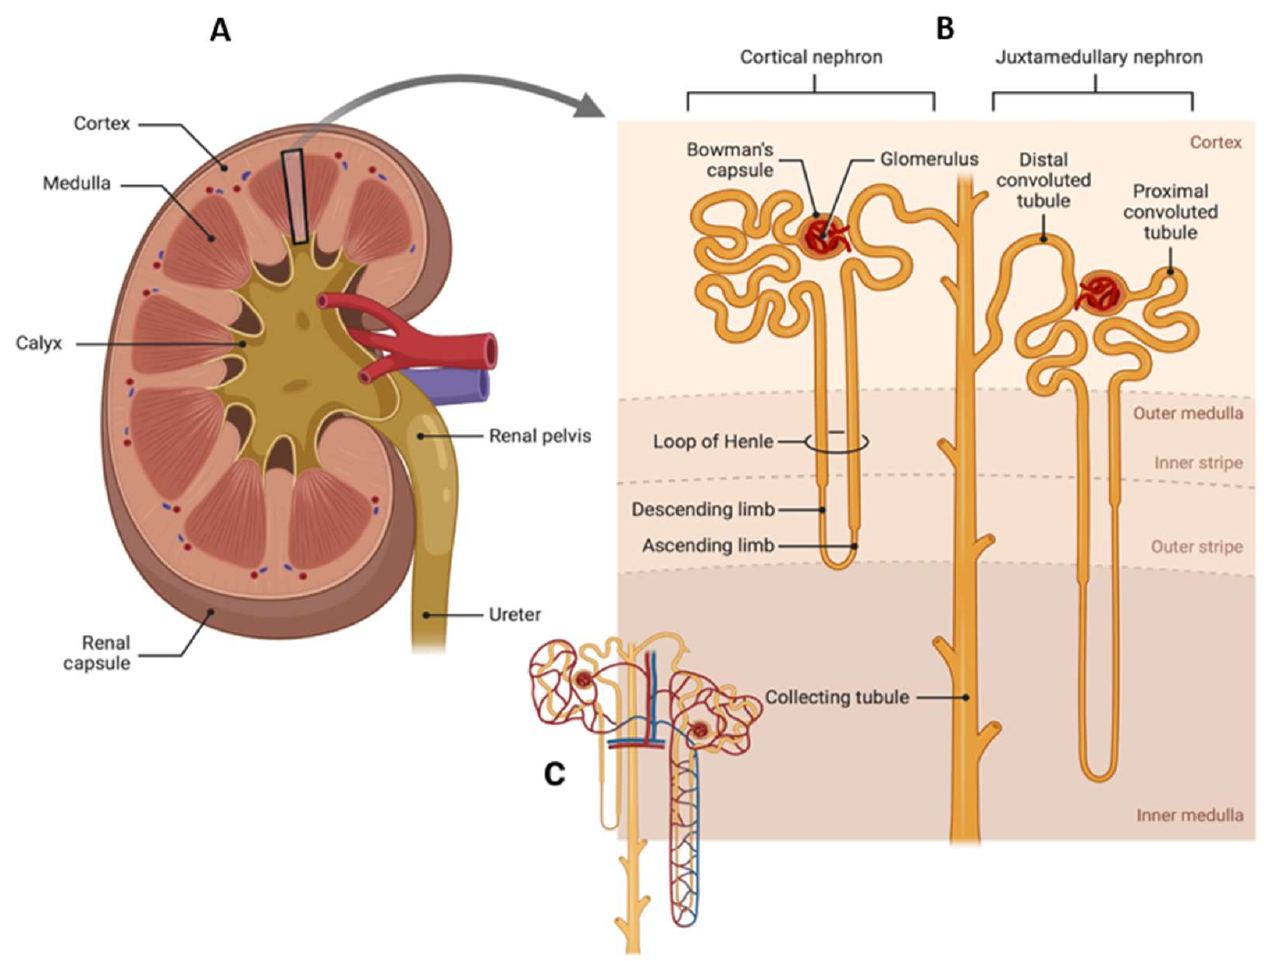
Figure 1. Schematic presentation of the renal system. ( A ) human kidney, ( B ) nephron, and ( C ) nephron with blood capillaries.